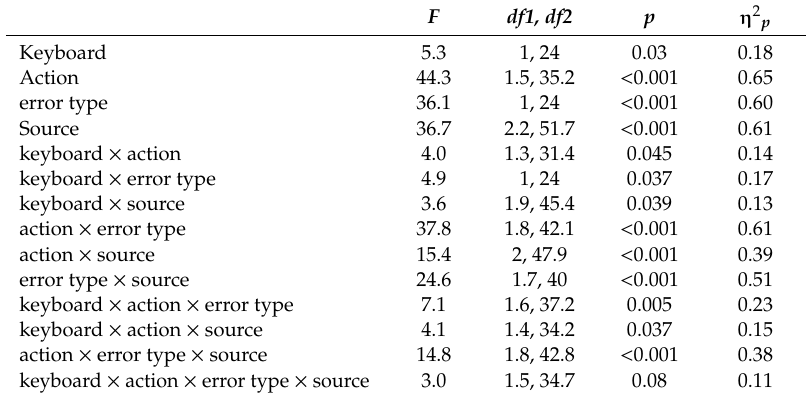
Table 3. Statistical values of the ANOVA on the number of reported errors. Factors and factor levels were action (execution with visible screen, execution with covered screen, imagination), error type (higher-order planning, motor command), source (reviewing the planning process, vision of the screen, vision of the keyboard, kinesthesis / touch, internal monitoring), and keyboard (visible and